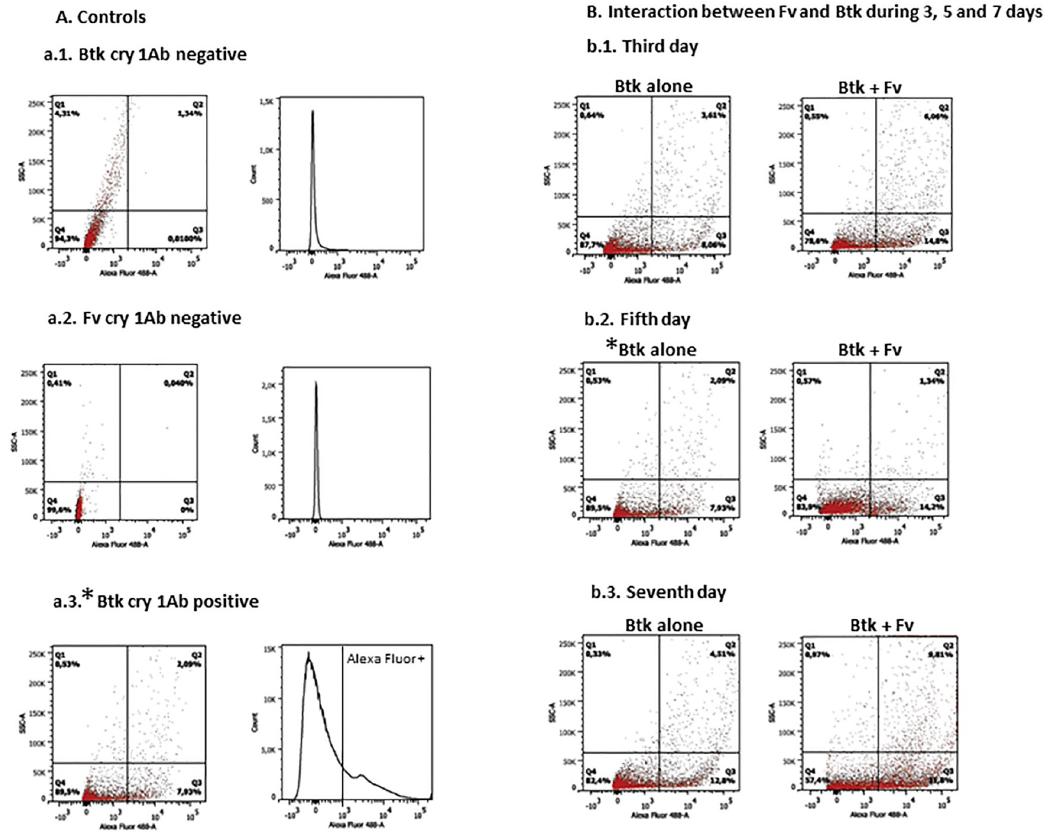
Fig 3. Flow cytometry analysis for quantification of Cry 1Ab toxins. Histograms show the number of Cry 1Ab toxins against the fluorescence intensity. Dot plot graphs show protein size (SSC) against fluorescence intensity. The vertical lines define the baseline above which the fluorescence is positive. (A) Experimental controls. (a.1.) Negative control– Btk cell suspension treated with secondary antibody coupled with Alexa Fluor 488; (a.2.) Fv cells treated with the first and secondary antibodies; (a.3.) Positive control– Btk cell suspension treated with antibody to Cry 1Ab toxin and secondary antibody. (B) Analysis of Cry 1Ab production during 3, 5 and 7 days of Fv + Btk interaction. (b.1.) Third day: Btk + Fv interaction and Btk Cry 1Ab toxin stained with Alexa Fluor 488; (b.2.) fifth day; (b.3.) seventh day. � Fifth day, Btk alone was also used as positive control for Btk , with the purpose of showing the positive histogram for Cry 1Ab marked with Alexa Fluor